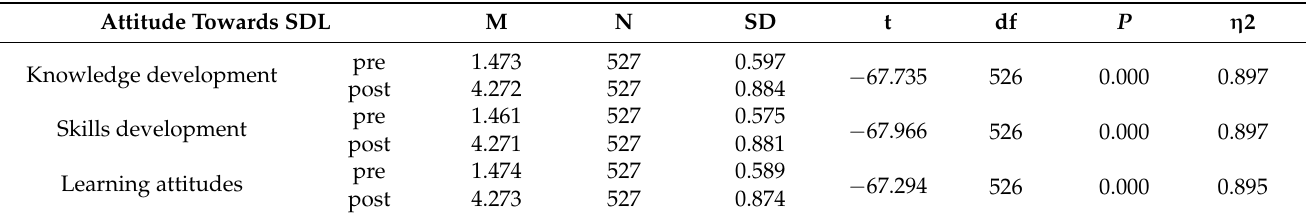
Table 6. The results of paired sample t -test in relation to attitude towards